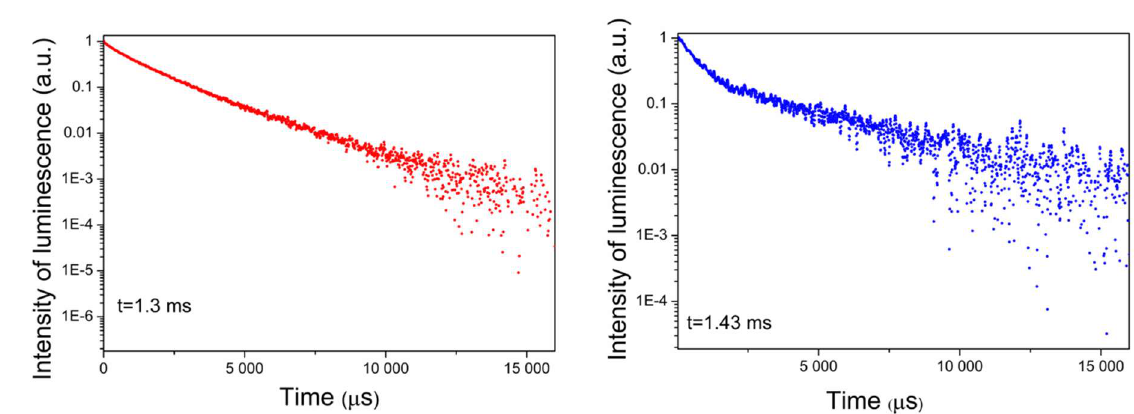
Figure 10. Luminescence decay curves for willemite sample W2 measured at T = 300 K and T = 77 K (red and blue line, respectively).